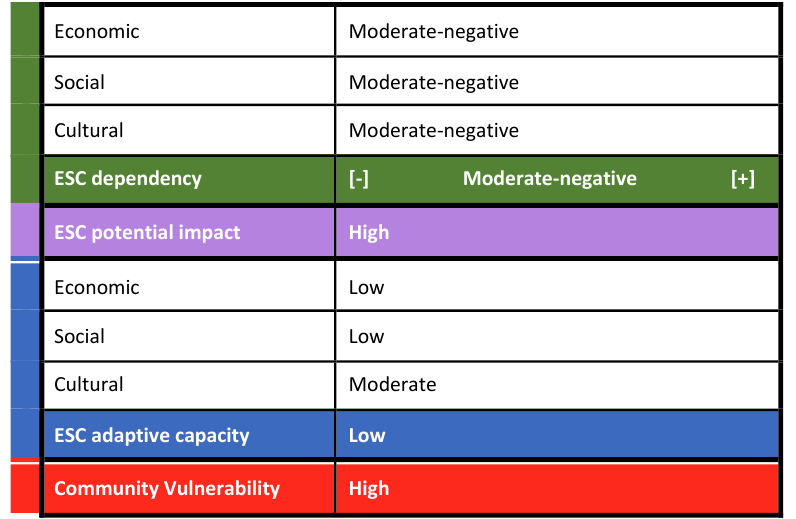
Table 5.3 Rapid assessment of Community Vulnerability to identified three key climate stressors. Assessed values of economic, social and cultural (ESC) dependency (sensitivity, ranging from negative to positive) and adaptive capacity contribute to derived outcomes for ESC potential impact and Community